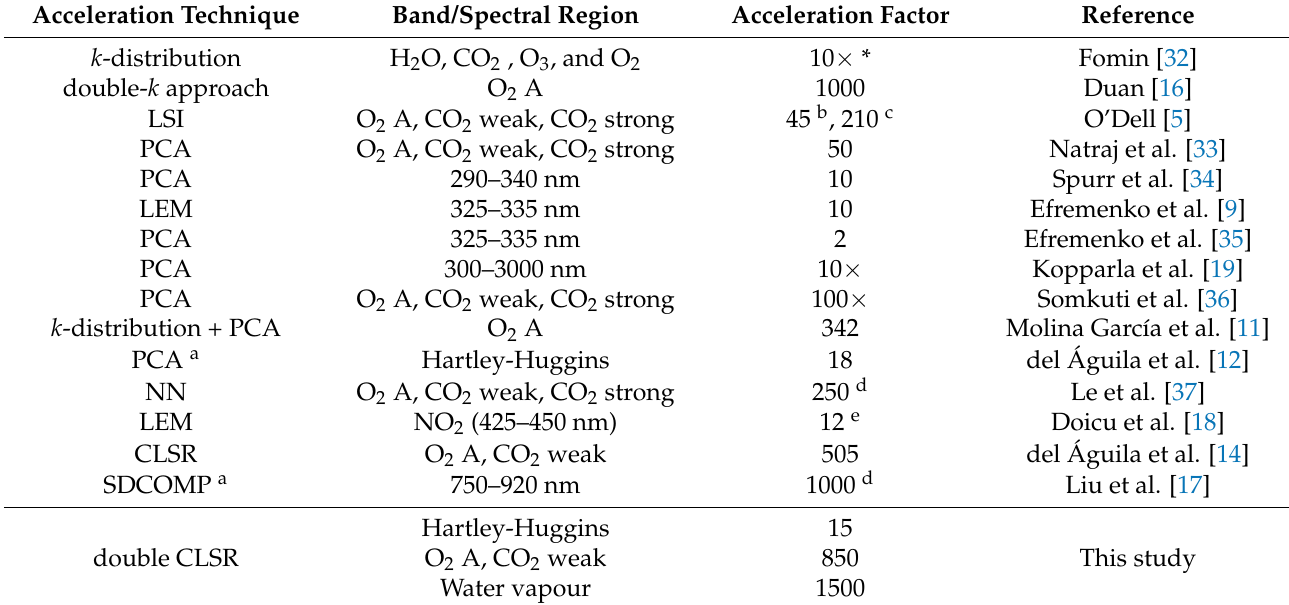
Table 5. Selected acceleration techniques with the corresponding spectral region or band, acceleration factor (computed with respect to the LBL model) and their reference. Note that the acceleration factors are sometimes given in orders of magnitude compared to the LBL approach. One or two order of magnitude are indicated as 10 × and 100 × , respectively. The references are ordered